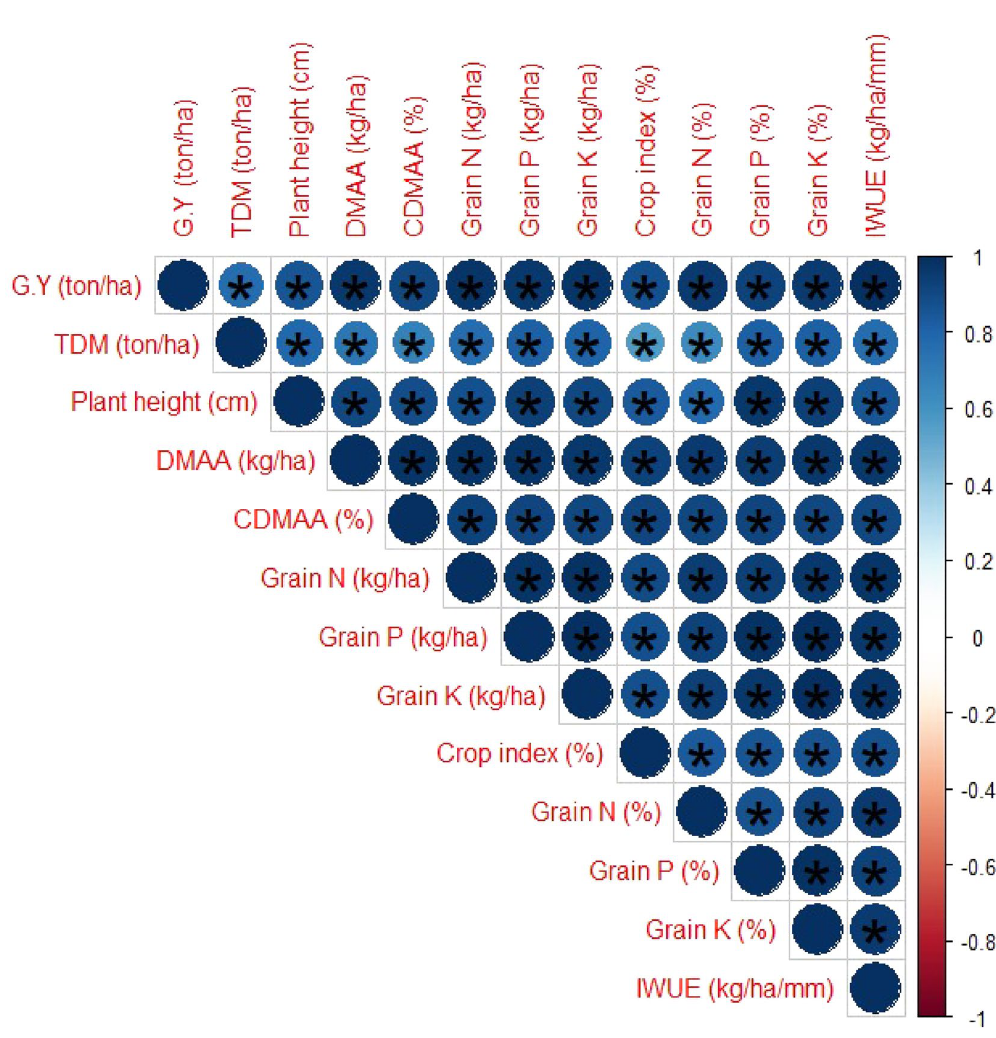
Figure 3. Correlation of various soil nutrients with yield, crop index (%), irrigation water use efficiency (kg ha −1 mm −1 ) at various N rates and slow release fertilizers. The circle’s areas depict the absolute result of corresponding correlation coefficients tested at *0.01 significance level. Light and dark blue colors depicted the minimum and maximum values. Star (*) and non-star presented significance and non-significance. GY grain yield, TDM total dry matter, Grain N grain nitrogen, Grain P grain phosphorus, Grain K grain potassium, Irrigation WUE irrigation water use efficiency, DMAA dry matter accumulation after anthesis, CDMAA contribution of dry matter accumulation after anthesis to wheat